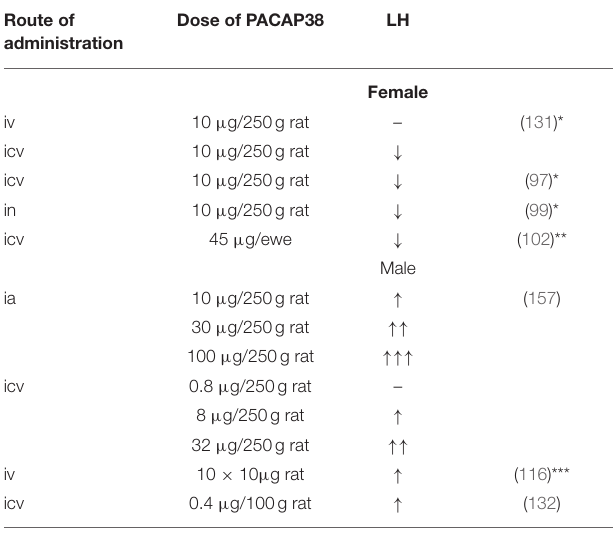
TABLE 1 | Effect of PACAP38 on the LH level in vivo